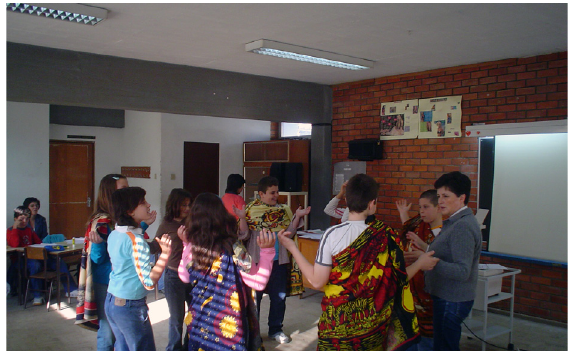
2 | Fig. 2: 6th Grade classroom - African Music, Culture and Traditions.